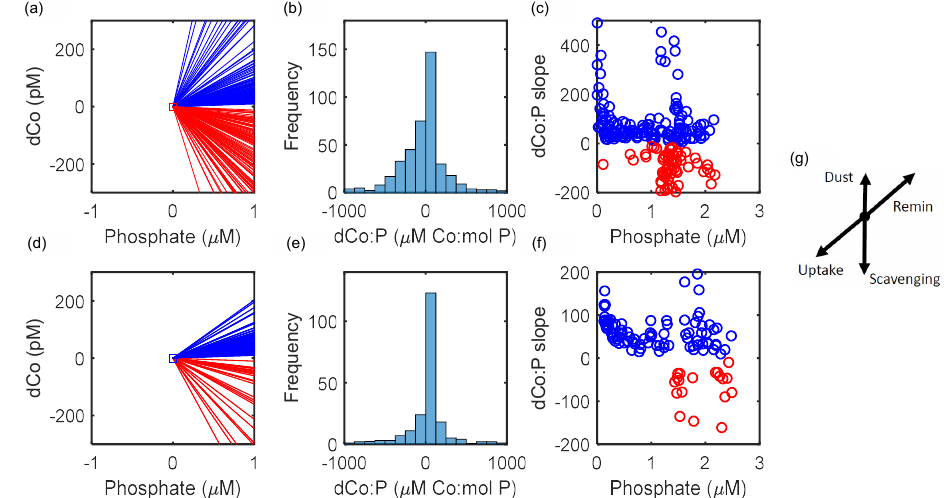
Figure 4. Vectors measured by five-point moving window linear regression for (a) the North Atlantic GA03/3e zonal section, and (d) the South Atlantic GAc01 zonal section. Blue and red colors correspond to the positive and negative slopes as described in Fig. 3. Vector lengths were made larger than the plot since they do not present information in this diagram. Histograms of frequencies of dCo:P slopes for the (b) North and (e) South Atlantic. dCo:P slopes relative to phosphate abundances in the (c) North and (f) South Atlantic, with increasing ratios observed as phosphate is depleted. (g) Schematic of idealized vectors for processes that influence dissolved cobalt (modified from Noble et al., 2008). Water mass mixing is not included since its contribution ratio can vary and because it is not a process that is capable of shifting these elements between dissolved and particulate phases.